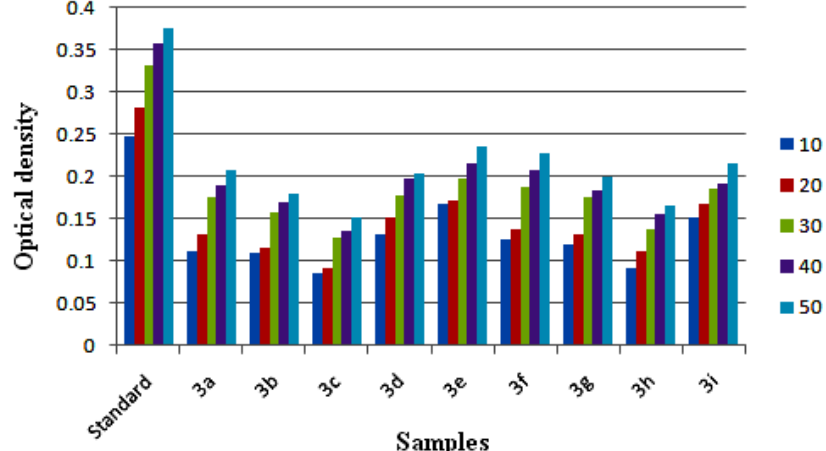
Figure 15. Cupric ion reducing power ability of samples 3 ( a – i ) at different concentration (10–50 μ g/mL) measured at 700 nm. Values are expressed as absorbance; high absorbance indicates high reducing